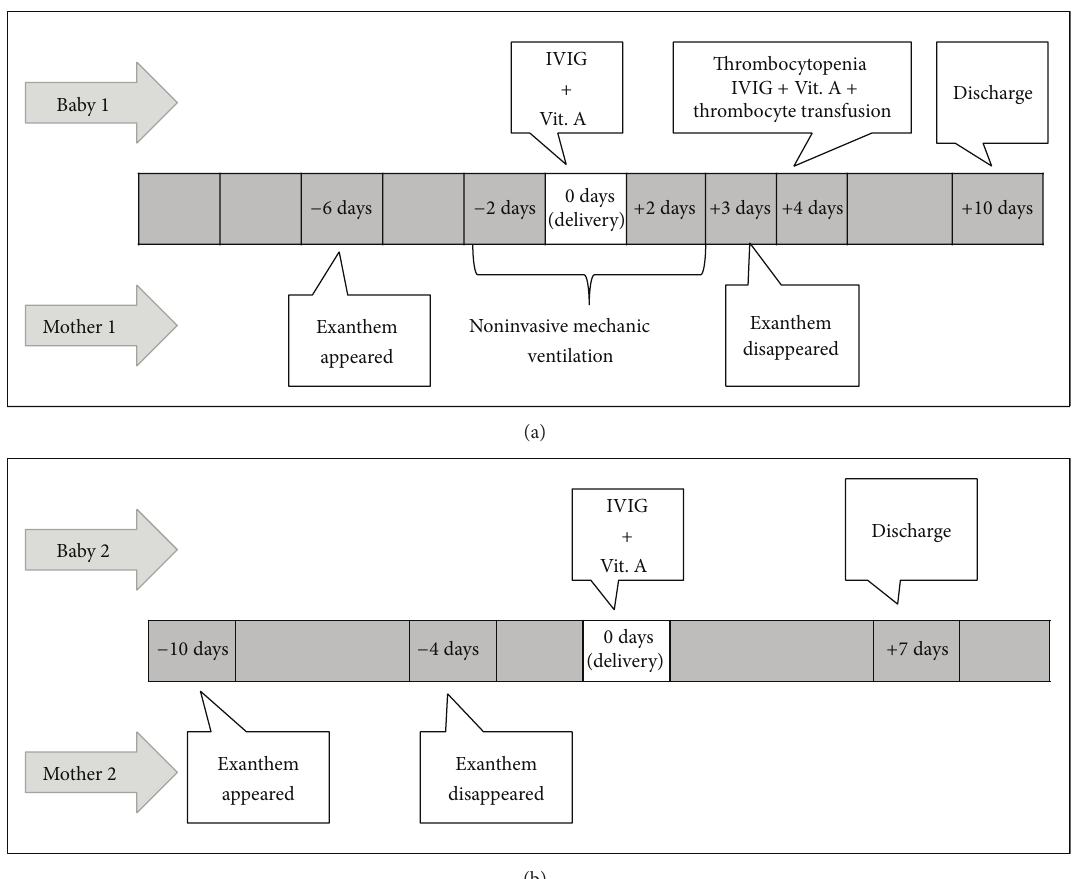
Figure 1: Clinical follow-up of infants and mothers described in Case 1 (a) and Case 2